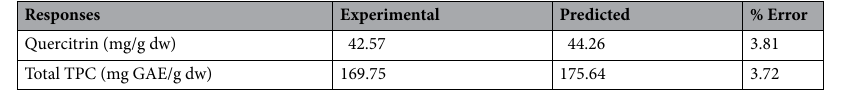
Table 4. Quercitrin and TPC yield under optimal ultrasonic extraction conditions.